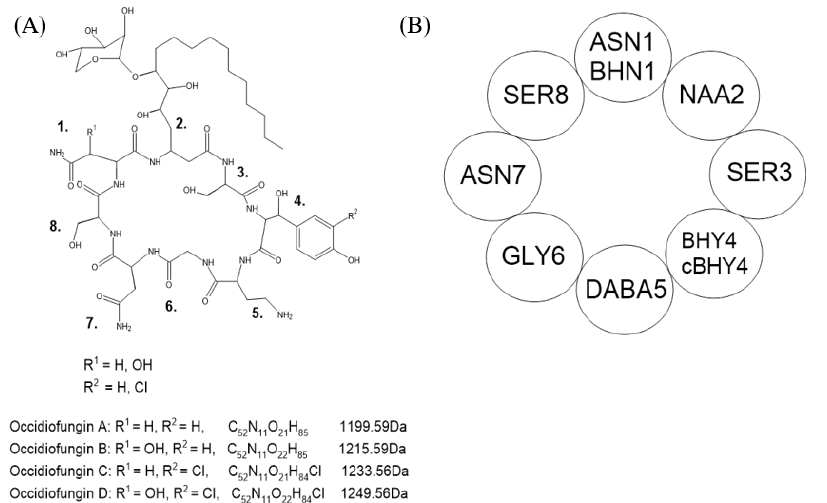
Figure 1. Chemical structure of occidiofungin. (A) Variants with their corresponding chemical formula and monoisotopic masses. Variants differ in R1 and R2 at amino acids designated as position 1 and 4. (B) Simplified structure with amino acids and their designated positions. Adapted from Gu et al. [12].